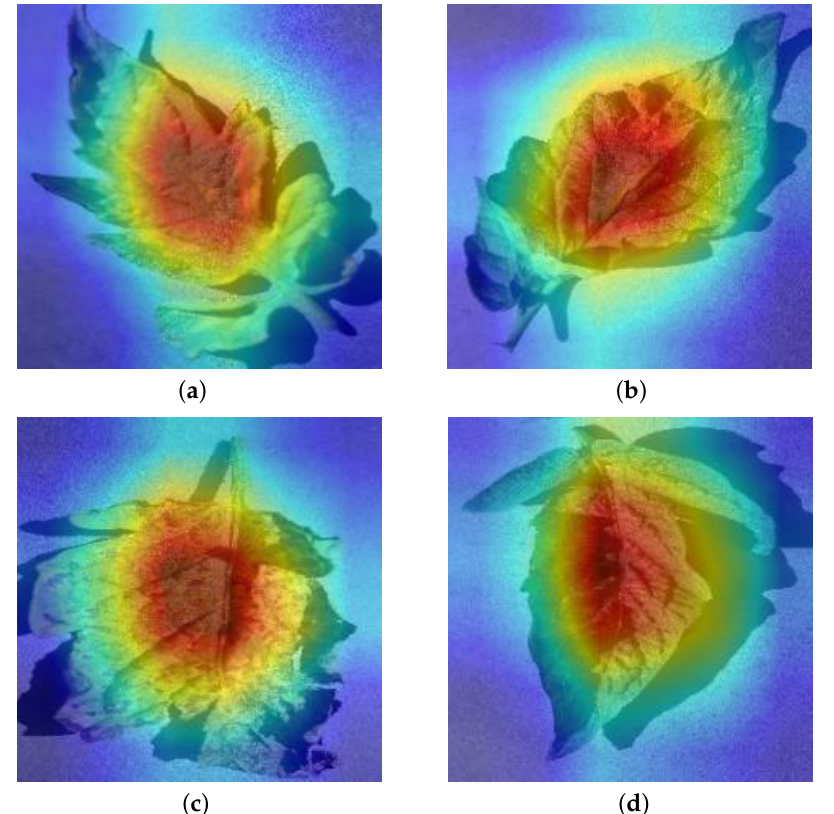
Figure 2. Visual explanations of tomato disease. ( a ) Leaf mold; ( b ) Late blight; ( c ) Septoria leaf spot; ( d ) two spotted spider